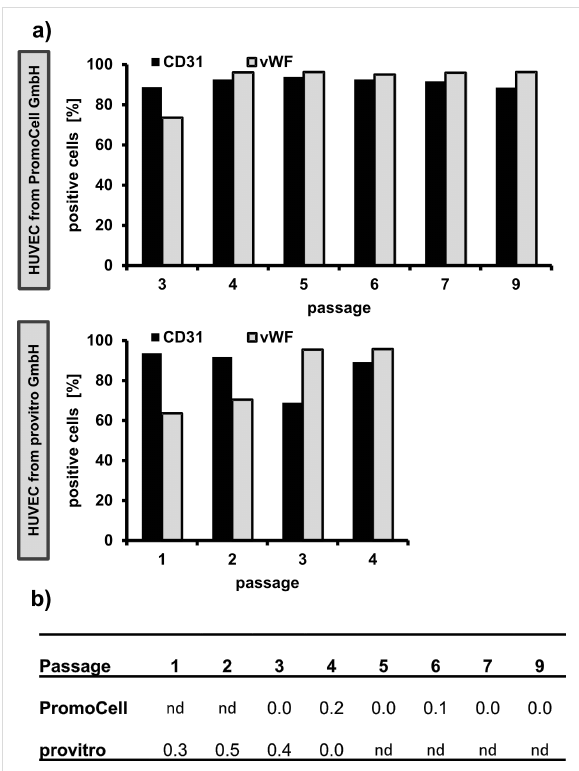
Figure 1: The HUVEC populations were pure and retained the endothelial phenotype during the experiment. a) Proportion of CD31 + and vWF + cells [%]. The endothelial phenotype was determined via the detection of von Willebrand factor (vWF) and CD31 (platelet endothe- lial cell adhesion molecule 1 (PECAM-1)). b) Proportion of CD90 + cells [%]. For purity examinations, CD90 as fibroblast cell type specific marker was determined. The investigations were performed on up to 9 passages and on HUVEC from two different suppliers (PromoCell GmbH and provitro GmbH). nd: not